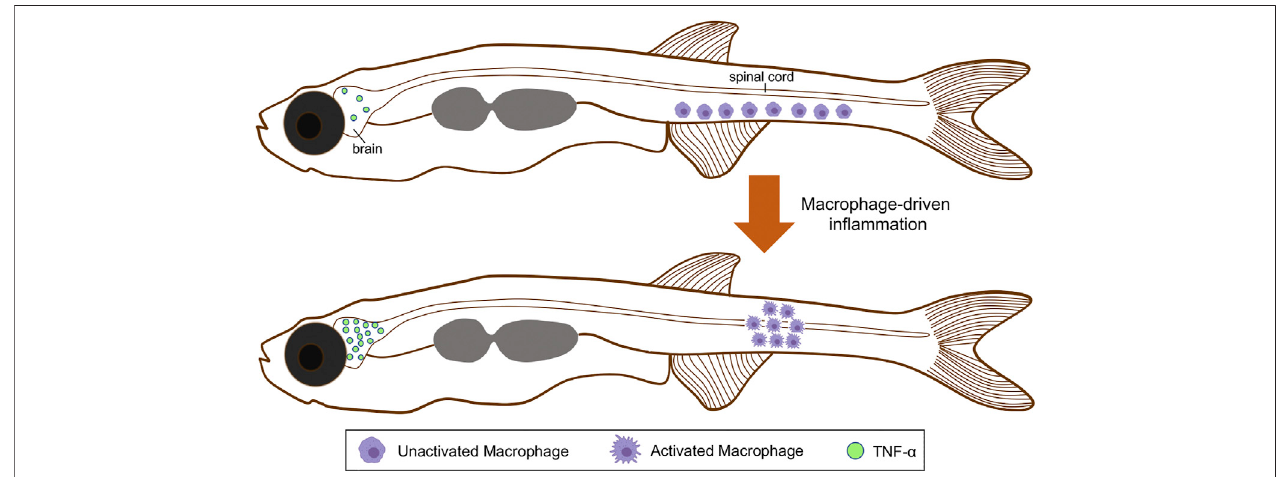
FIGURE 3 | Schematic representation of macrophages activation and spatial distribution, and the regionalized in fl ammatory response triggered during scoliosis development. Colored macrophages (purple) are shown. At the onset of the spinal curve formation, immature macrophages are distributed along the ventral side of the tail. After their activation, these cells move and accumulate within the spinal cord. Macrophages maturation also triggers a neuroin fl ammatory response associated with TNF- α overexpression in the brain. TNF- α , tumor necrosis factor alpha.